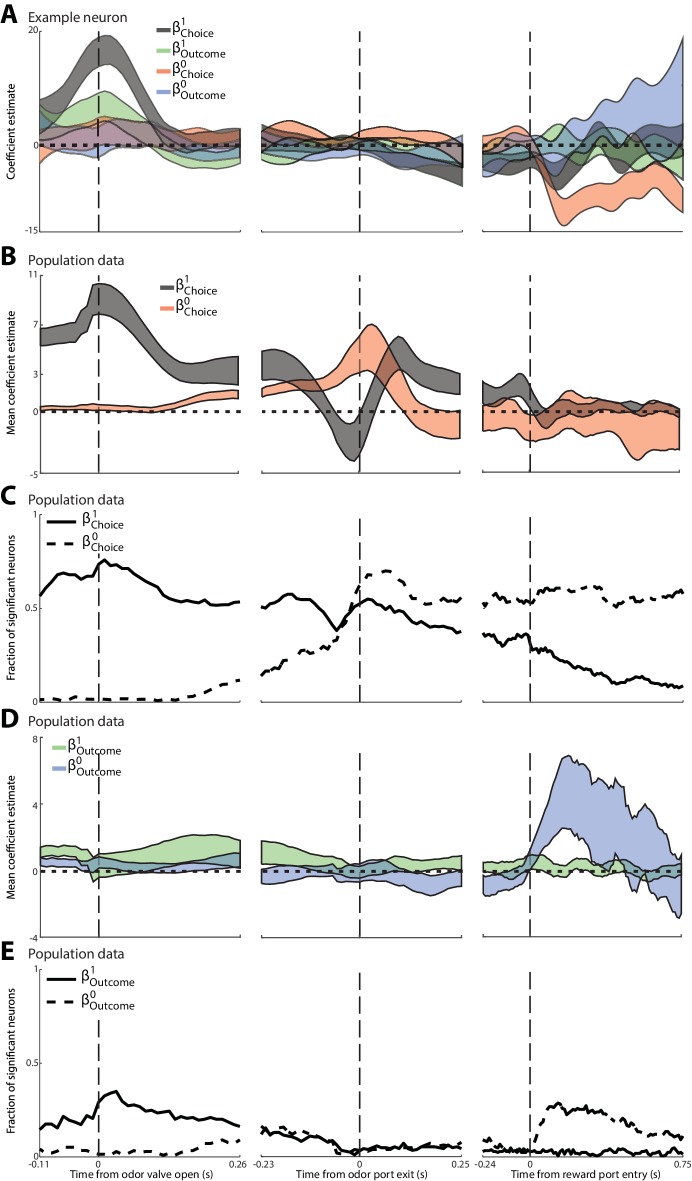
Dynamics of the influence of the choice and outcome on the previous and current trial on PPTg activity throughout the trial.(A) For the example neuron shown in Figure 3, 95% confidence intervals are shown for each regression coefficient calculated in 100 ms bins (shifted by 10 ms), aligned to three trial events. (B) Average regression coefficients across all neurons that exhibited a significant preference for choice on the previous trial. Ribbons reflect mean ± SEM β Choice1 (black) β Choice0 (red) coefficient values as a function of time. (C) Fraction of neurons with activity in each 100 ms bin significantly influenced by choice on the previous or current trial, aligned as in A. (D) As in B, with respect to outcome instead of choice. (E) As in C, with respect to outcome instead of choice.